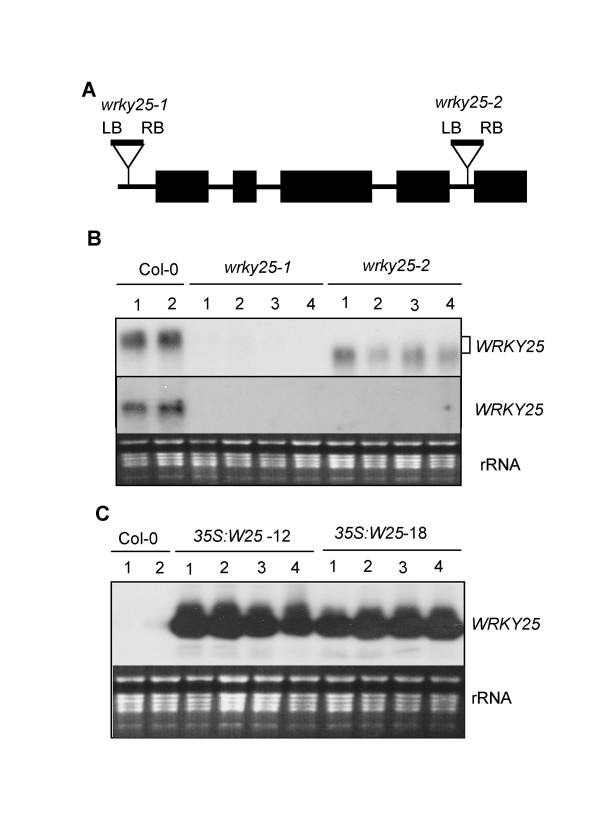
Characterization of wrky25 T-DNA insertion mutants and transgenic overexpressing plants. A. Diagram of WRKY25 gene and its T-DNA insertion mutants. B. RNA blot analysis of wrky25 mutant lines. Four hours after inoculation with PsmES4326 (OD600 = 0.0001), the inoculated leaves from two wild-type plants (Col-0) or four wrky25-1 and wrky25-2 mutant plants were harvested and total RNA was isolated. After separation and blotting to a nylon membrane, the blot was probed with a full-length WRKY25 cDNA fragment (upper panel) or a WRKY25 DNA fragment corresponding to the region downstream of the T-DNA insertion in the wrky25-2 mutant (lower panel). Ethidium bromide stained rRNA was used as a loading control. C. RNA blot analysis of WRKY25 expression in transgenic plants constitutively overexpressing WRKY25. RNA samples were prepared from leaves of two wild-type plants (Col-0) or four plants from each tansgenic 35S:WRKY25 line and probed with a WRKY25-specific DNA probe. Lines 12 and 18 expressed elevated levels of WRKY25 and contain a single T-DNA insertion based on the ratio of antibiotic-resistant progeny. F3 homozygous progeny plants of the two lines were used for further analyses.